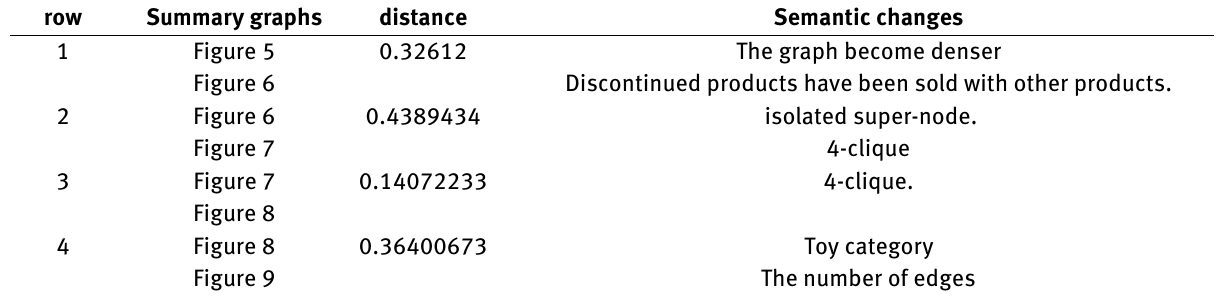
Table 4: semantic changes of the consecutive summary graphs row Summary